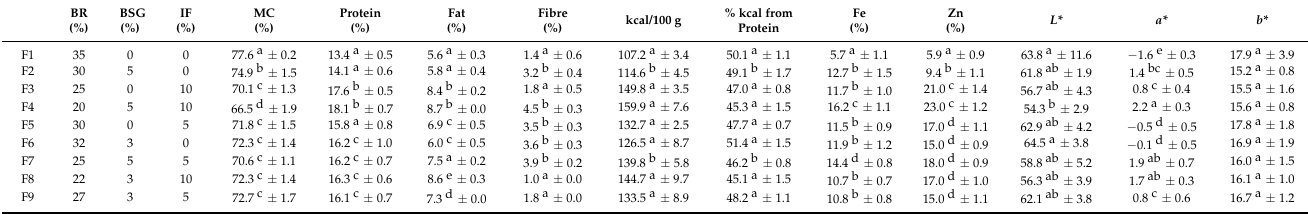
Table 2. Results for different formulations of hybrid sausages containing broccoli (BR), upcycled brewer’s spent grain (BSG) and insect flour (IF). Values show mean ± standard deviation, n =